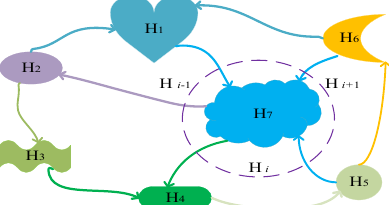
Figure 1. Diagram of species migration between habitats . Table 1. Correspondence between BBO algorithm and biogeography theory.